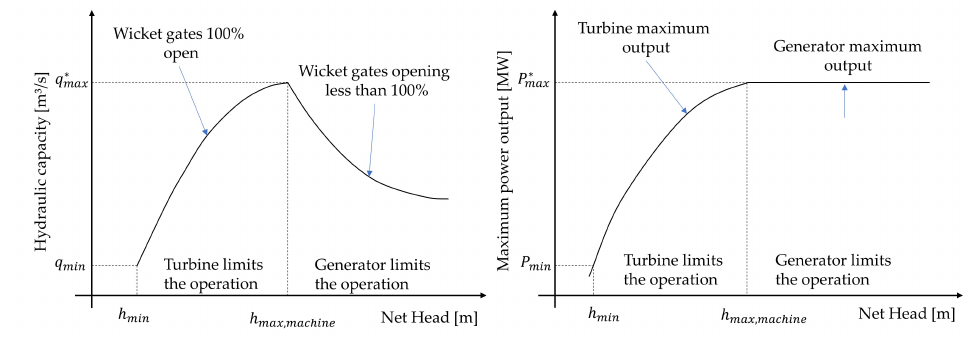
Figure A1. Hydraulic capacity and maximum power output of turbine-generator set as function of net head. Adapted from